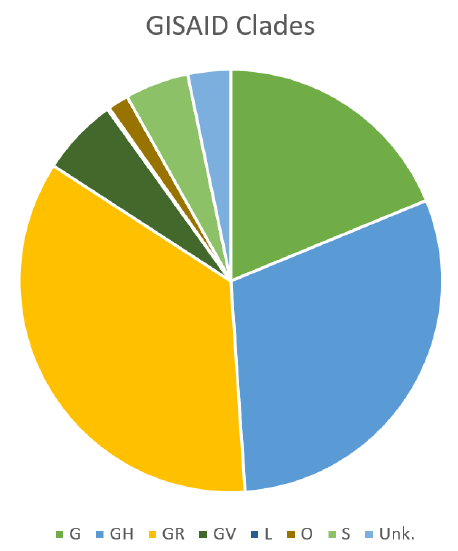
Figure 2. Subdivision in the Global Initiative on Sharing All Influenza Data (GISAID) clades of genomes included in this study.